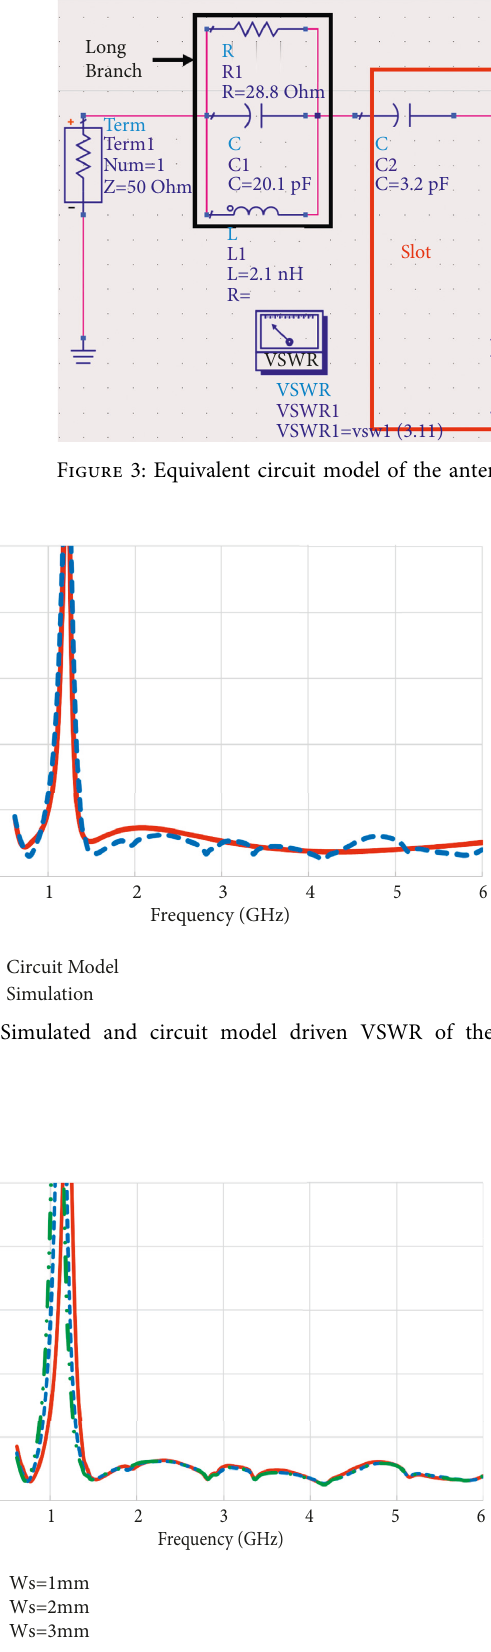
Figure 5: Effect of the slot width (Ws) on the antenna VSWR.